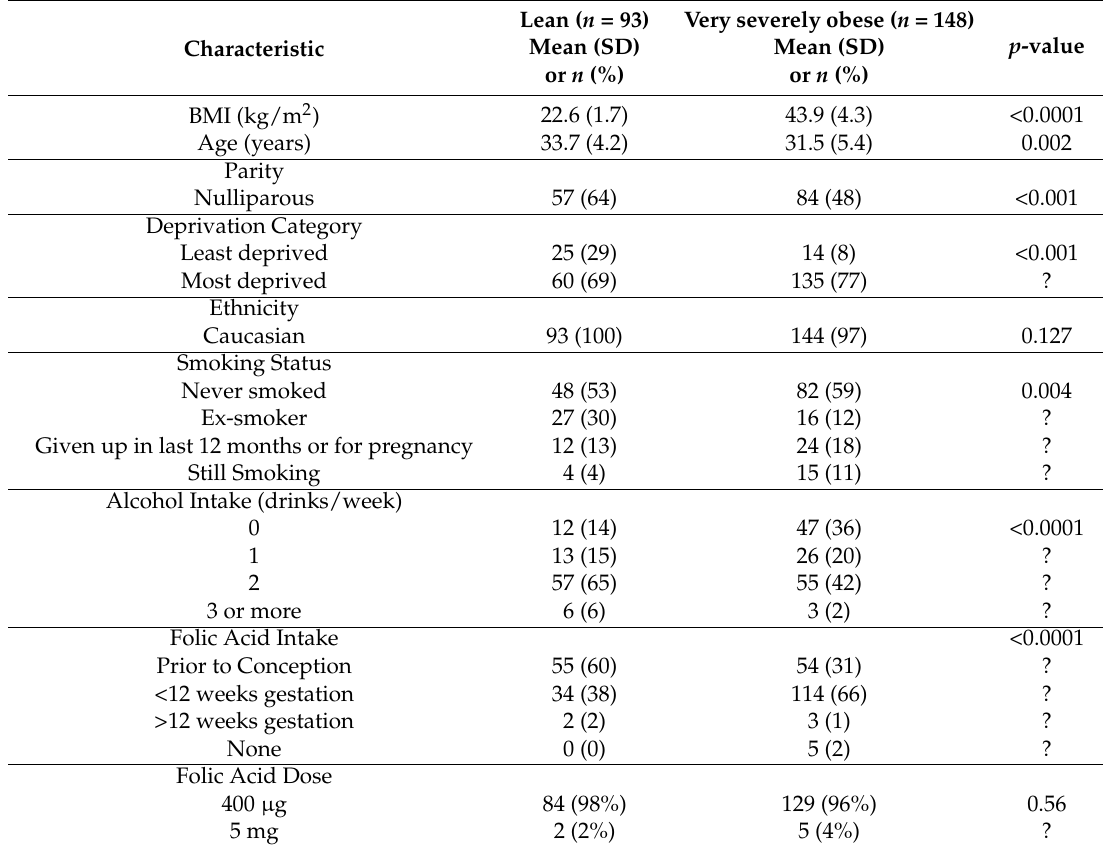
Table 1. Characteristics of study